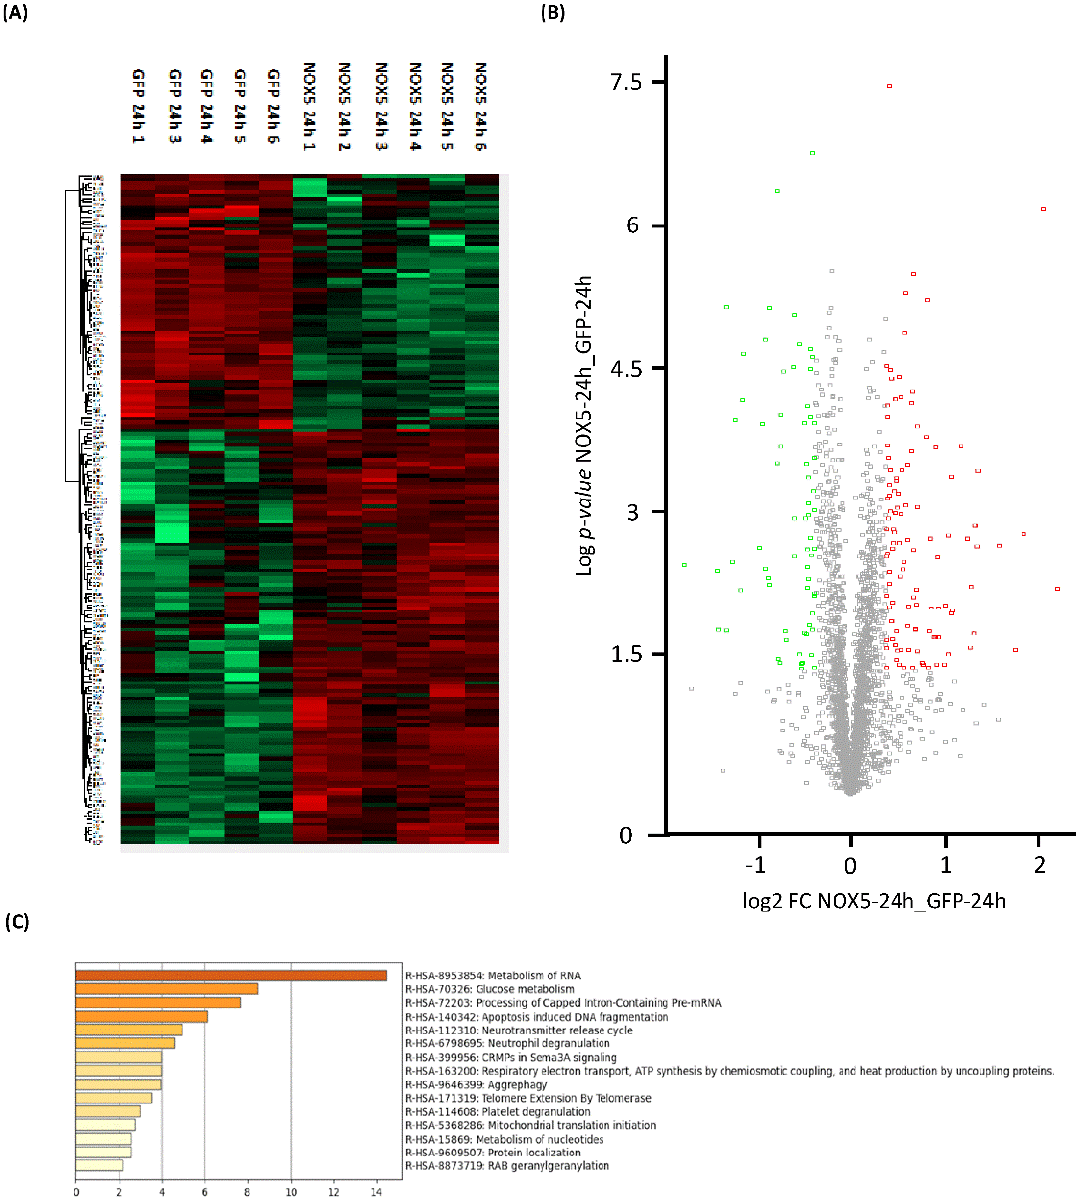
Figure 3. General proteomic analysis of hCMEC/D3 cells infected with GFP and NOX5- β adenovirus for 24 h. ( A ) Heatmap representation of protein differential expression between the two groups. ( B ) Volcano plot representation of samples analyzed. ( C ) Top-15 statistically enriched biofunctions derived from NOX5- β overexpression. GFP: GFP-infected hCMEC/D3 cells ( n = 5); NOX5: NOX5- β - infected hCMEC/D3 cells. ( n = 6).